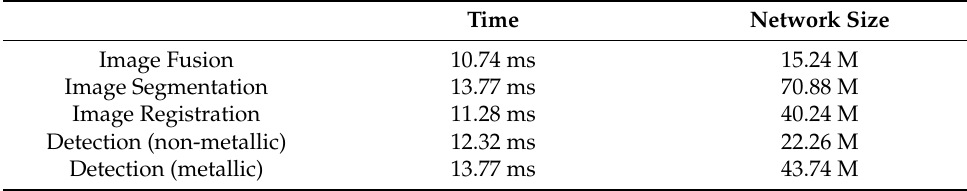
Table 5. Time Cost of each module in our method.